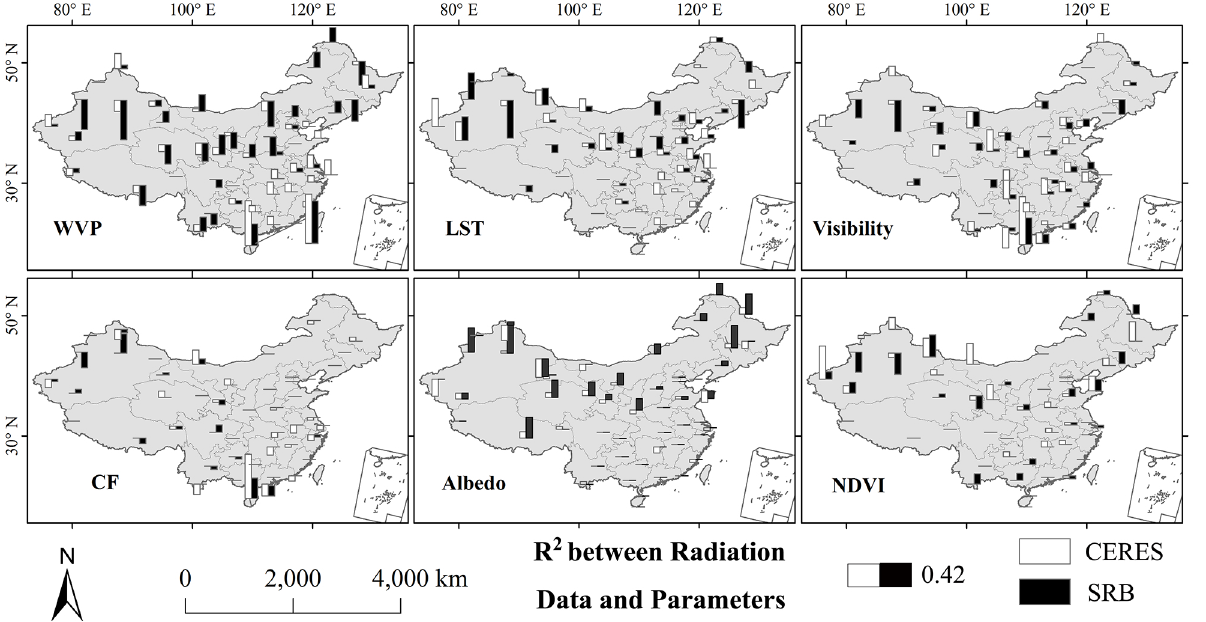
Figure 10. Spatial distributions of correlation coefficients (R 2 ) between environmental parameters and errors in NSW and NLW for CERES and SRB at 50